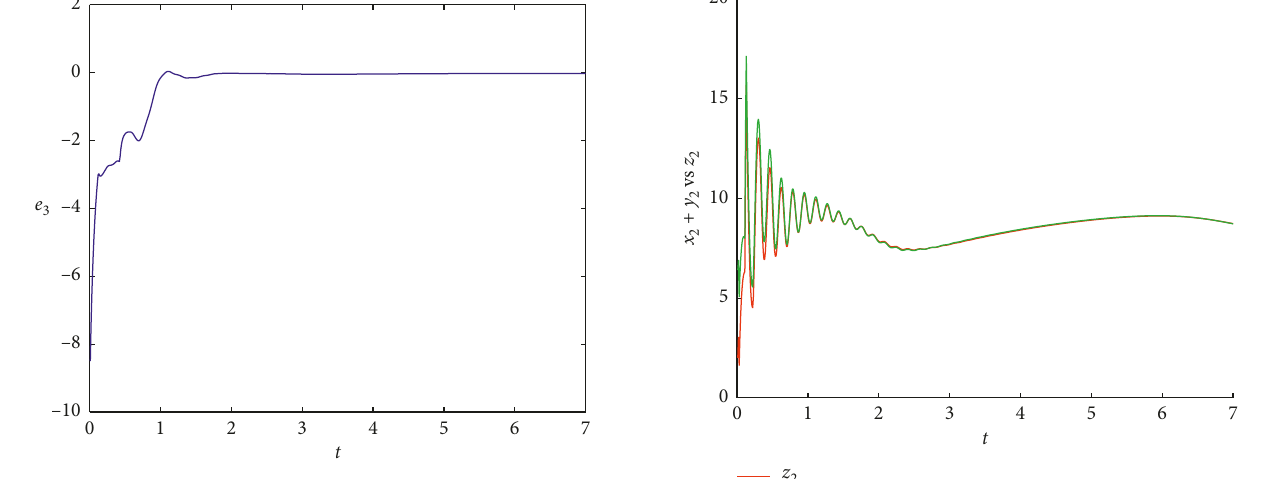
between drive 3